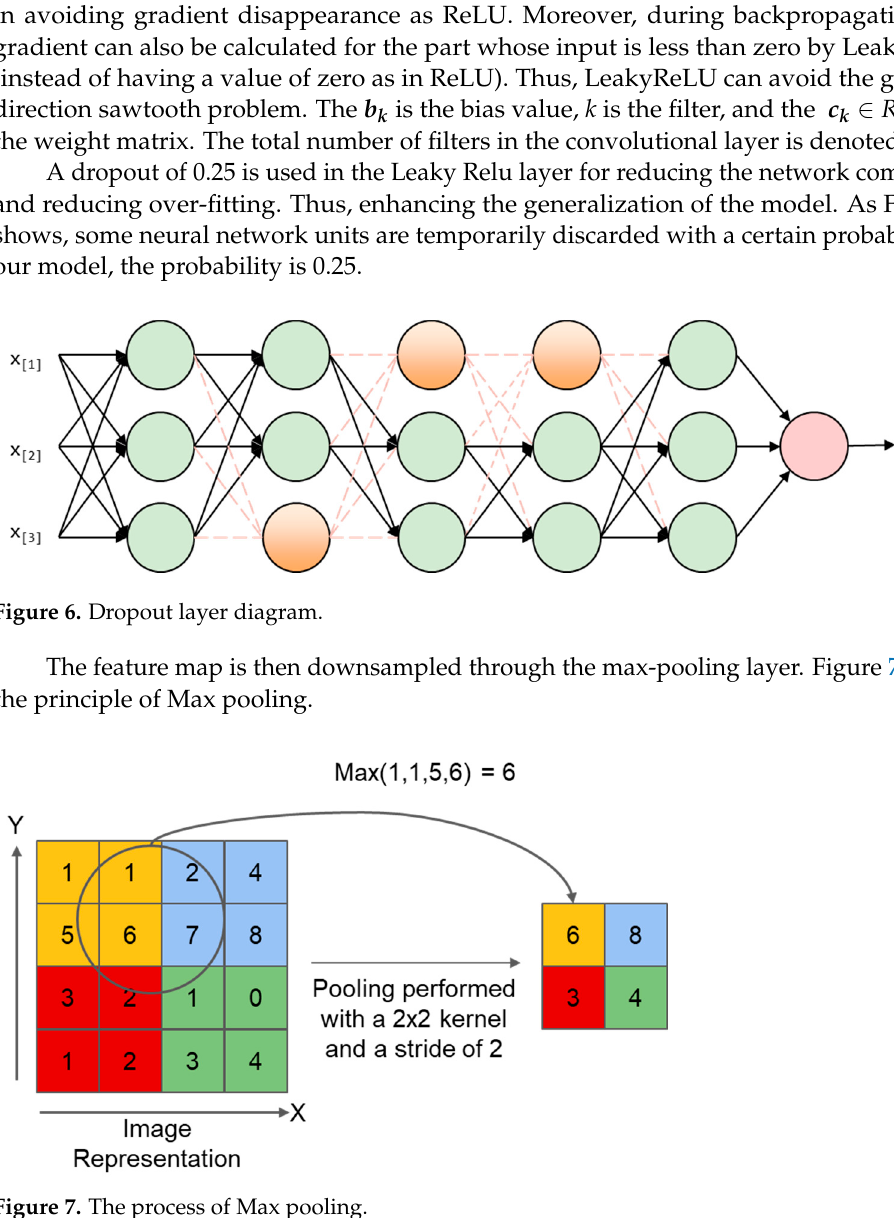
Figure 7. The process of Max